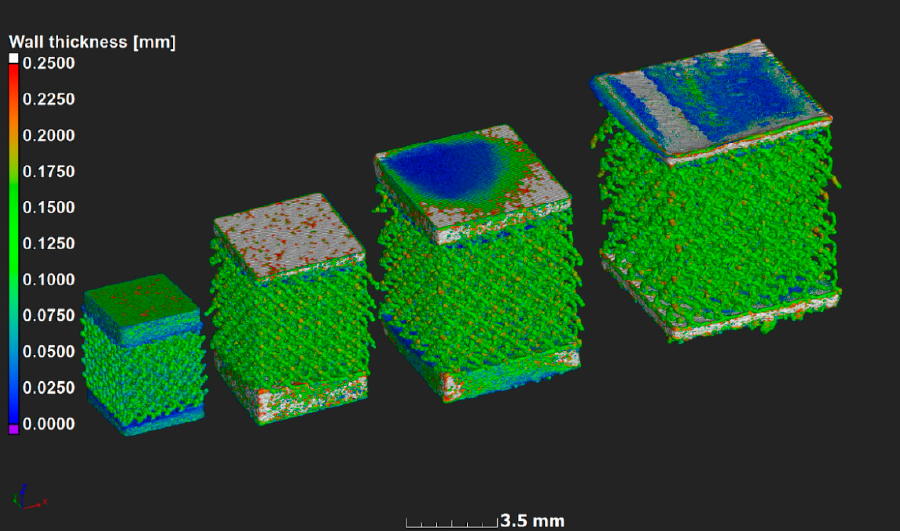
Figure 2 . MicroCT scan data 3-D rendering with strut thickness color coding on the microlattices. Models had a 0.6, 0.8, 1.0, and 1.2 mm unit cell size from left to right respectively; here the top and bottom of the samples were slightly cropped as the lattice area was scanned only. Dark blue indicates thin local walls and red indicates thick walls, thickest parts were excluded to highlight the important aspect. All lattice struts have similar thickness (0.1–0.15 mm).